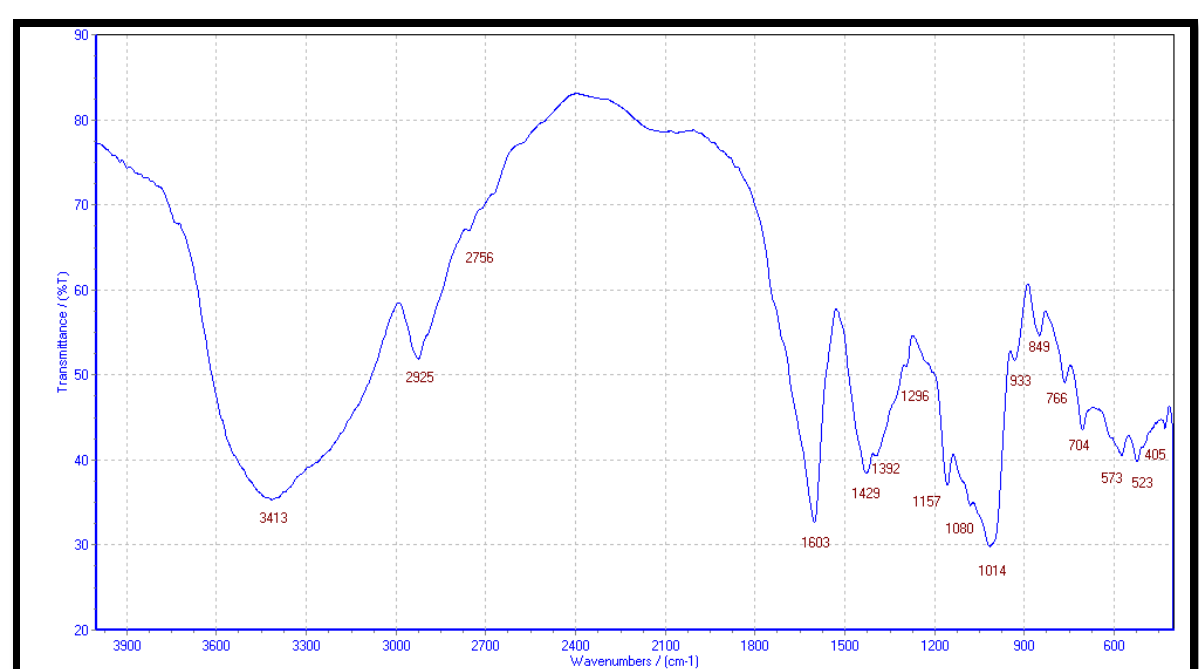
Figure 6. FTIR spectrum of